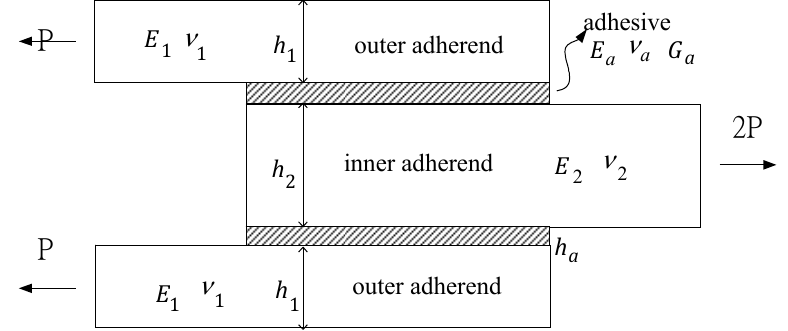
Figure 1. Geometric model for an adhesive double lap joint.